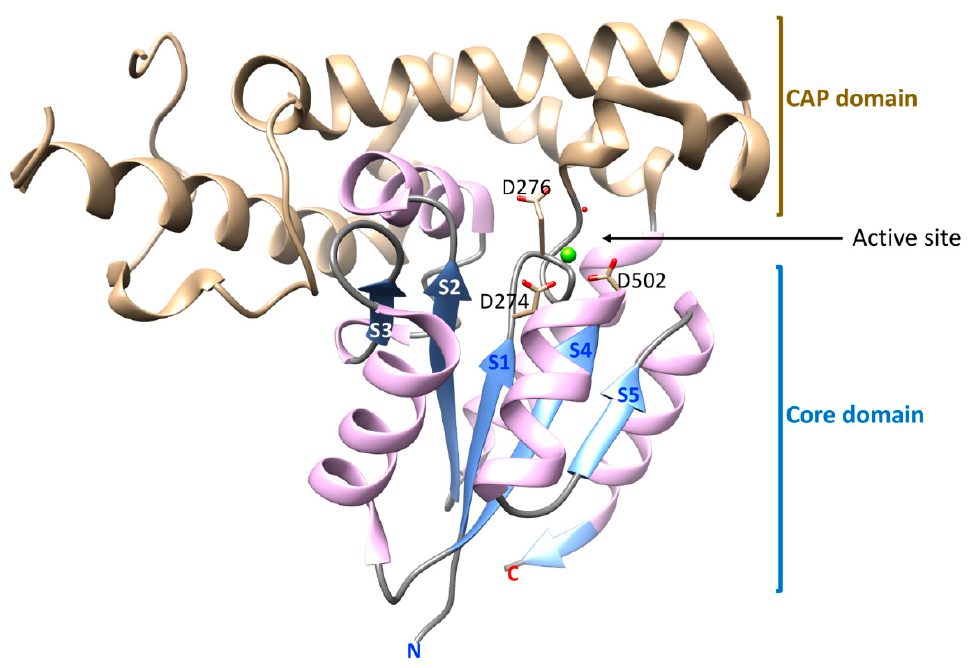
Figure 3. A ribbon drawing of the EYA2 ED domain generated using UCSF Chimera [17] from 3GEB.PDB [15]. The Mg 2+ ion is depicted as a green sphere. The core and cap domains, as discussed here, are shown. β -strands that make up the Rossmanoid HAD core structure are numbered S1–S5, going from N- to C-terminus of the domain. Amino acid side-chains in the active site (the nucleophilic Asp and the genral acid-base Asp in Motif I, and the Asp in Motif IV that co-ordinates the metal ion) are shown in the active site.